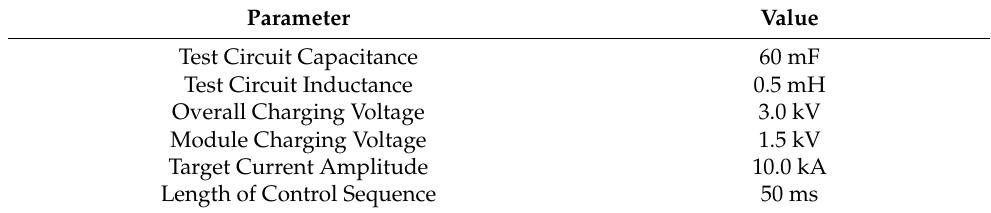
Table 4. Values of testing parameters for experimental demonstration of presented interconnection